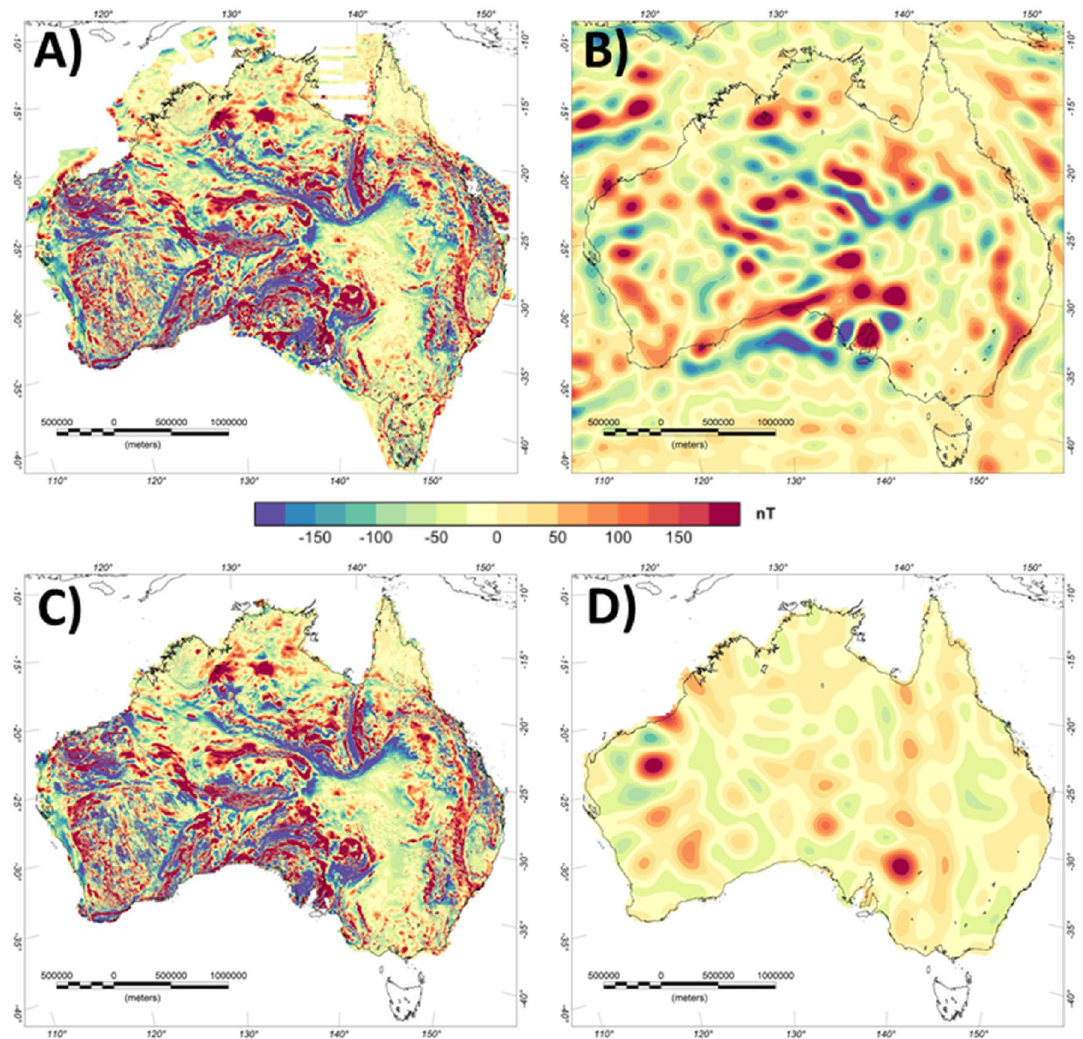
Figure 6. Lithospheric magnetic anomaly of Australia. ( A ) Original aeromagnetic compilation 20 , ( B ) Satellite- derived model LCS-1, ( C ) Conformed aeromagnetic and satellite model, ( D ) Difference between ( A , C